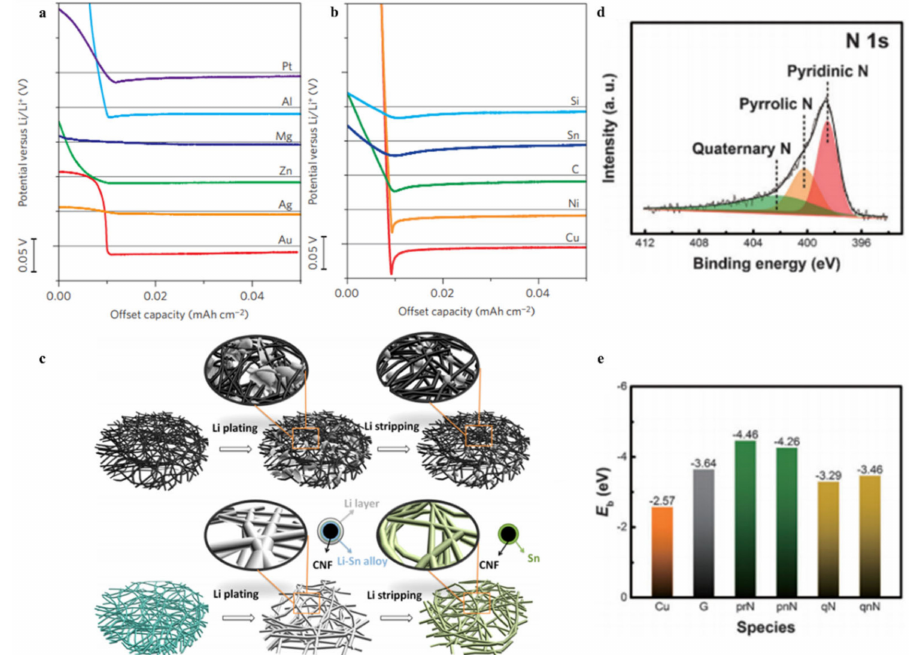
Figure 5. Lithiophilic behavior of heteroatoms and spared rGO. ( a , b ) Li nucleation voltage profile on various materials with some solubility and with negligible solubility at 10 µ A cm − 2 . Reproduced with permission from [83], Springer Nature, 2016. ( c ) Schematic illustration of Li plating / stripping behavior on a carbon nanofiber (CNF) with and without lithiophilic Sn. Reproduced with permission [88], American Chemical Society, 2019. ( d , e ) Core-level of N 1s XPS spectra in N-doped graphene and BE of Li atom with copper, graphene, and di ff erent functional groups of N-doped graphene. Reproduced with permission with [91], John Wiley and Sons,